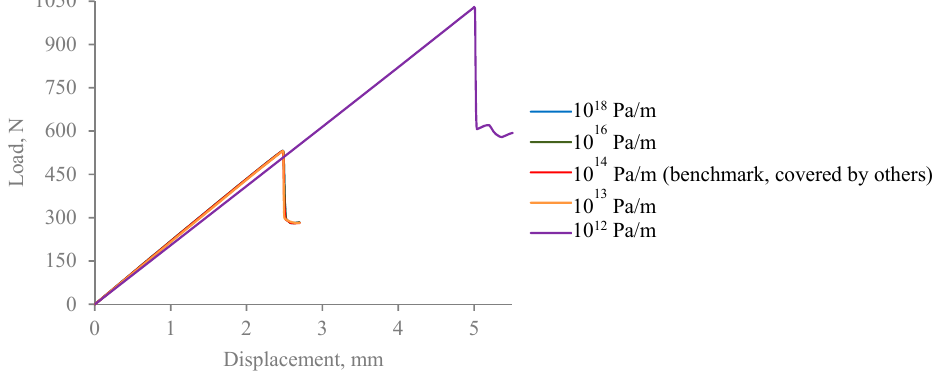
Figure 12. Sensitivity of load-displacement predictions in the Mode II model to value of the penalty shear stiffness.